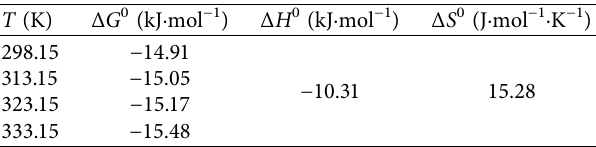
Table 4: Thermodynamic parameters for the adsorption of Cu(II) by